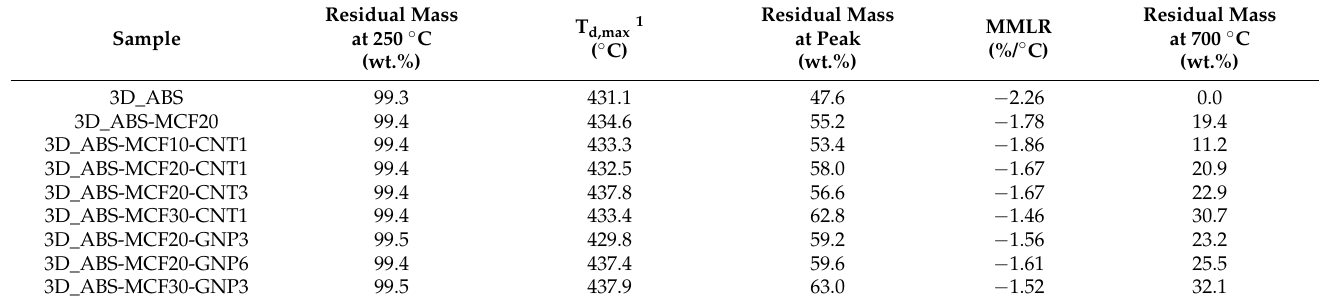
Table 7. TGA data of pure ABS and multiscale composite printed samples in a nitrogen atmosphere.